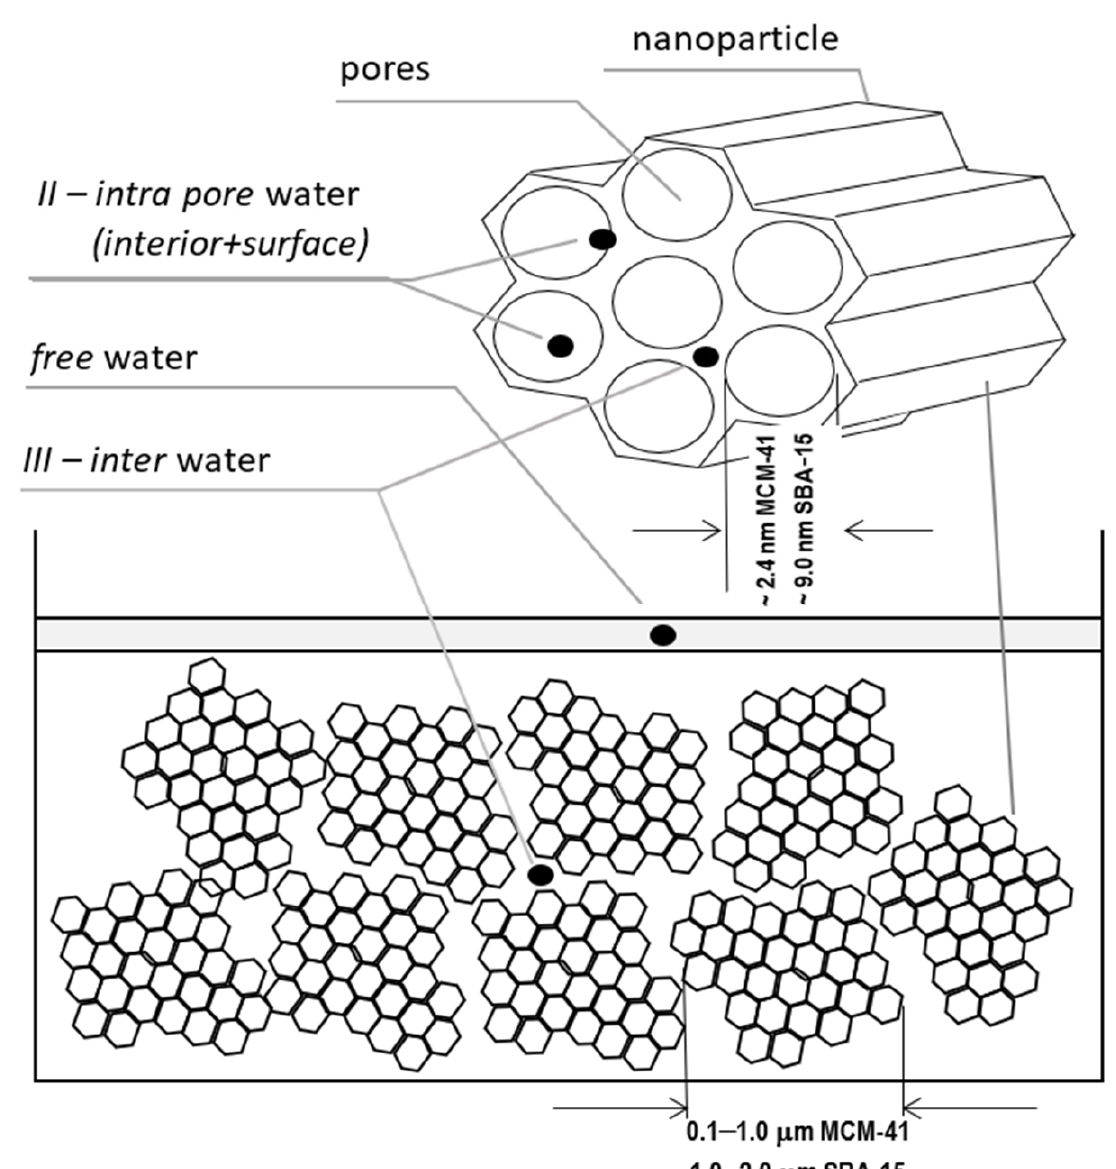
Figure 1. The considered locations for water placement: free water, water inside the pores (as the bulk and surface water), in-between the pores and nanoparticles.